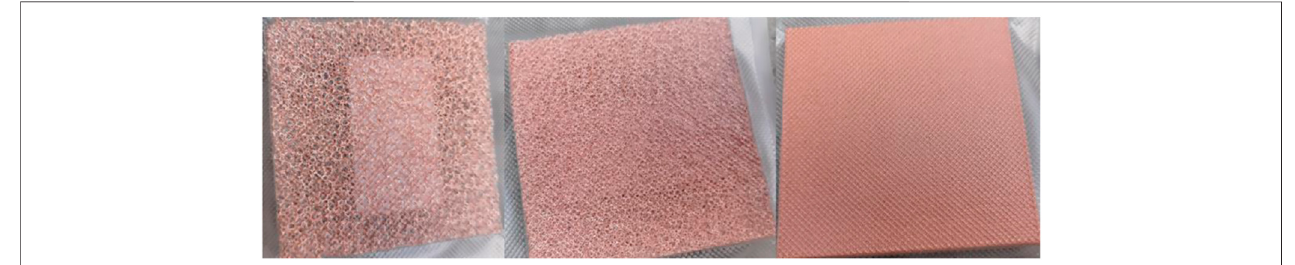
FIGURE 2 | Copper foam with the same porosity of 95 % and various pore densities of 15 ppi, 30 ppi, and 50 ppi (from left to right).